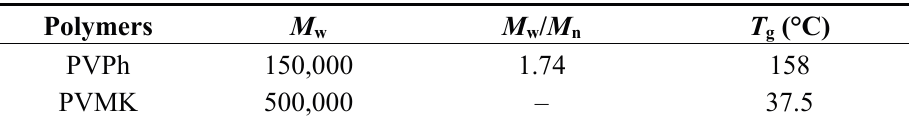
Table 1. Polymer